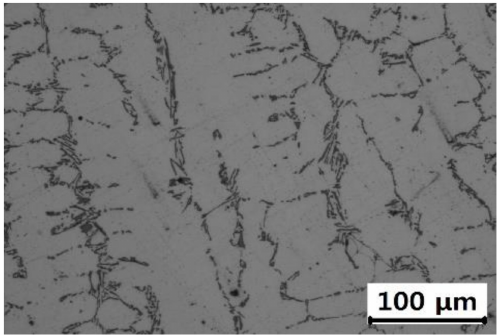
Figure 1. Optical micrograph of the as-cast Al6Si2Cu alloy showing the typical dendrite microstruc- ture of the gravity casting process.